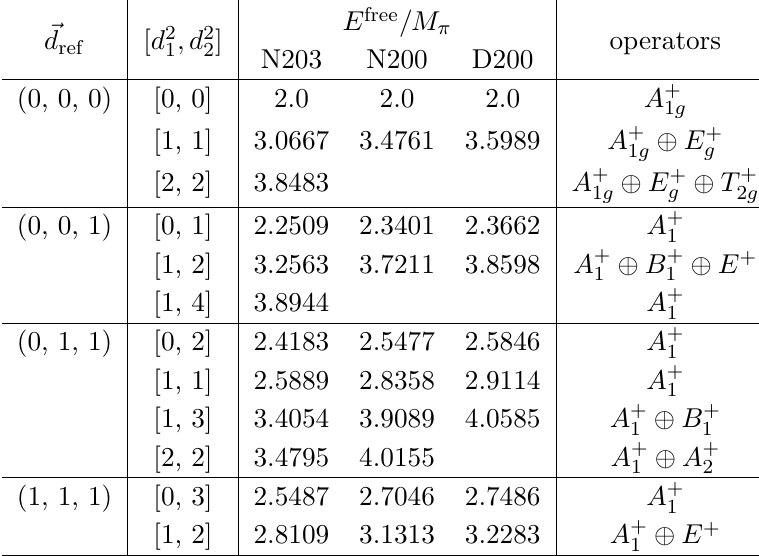
Table 27. Same as table 21 except for the two-pion operators with ~ d 2